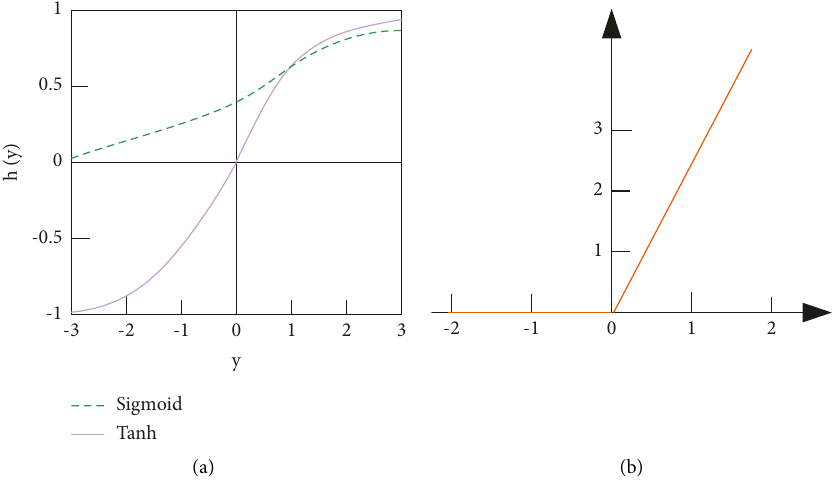
Figure 2: Three function images. (a) Sigmoid-Tanh function image. (b) ReLU function image.